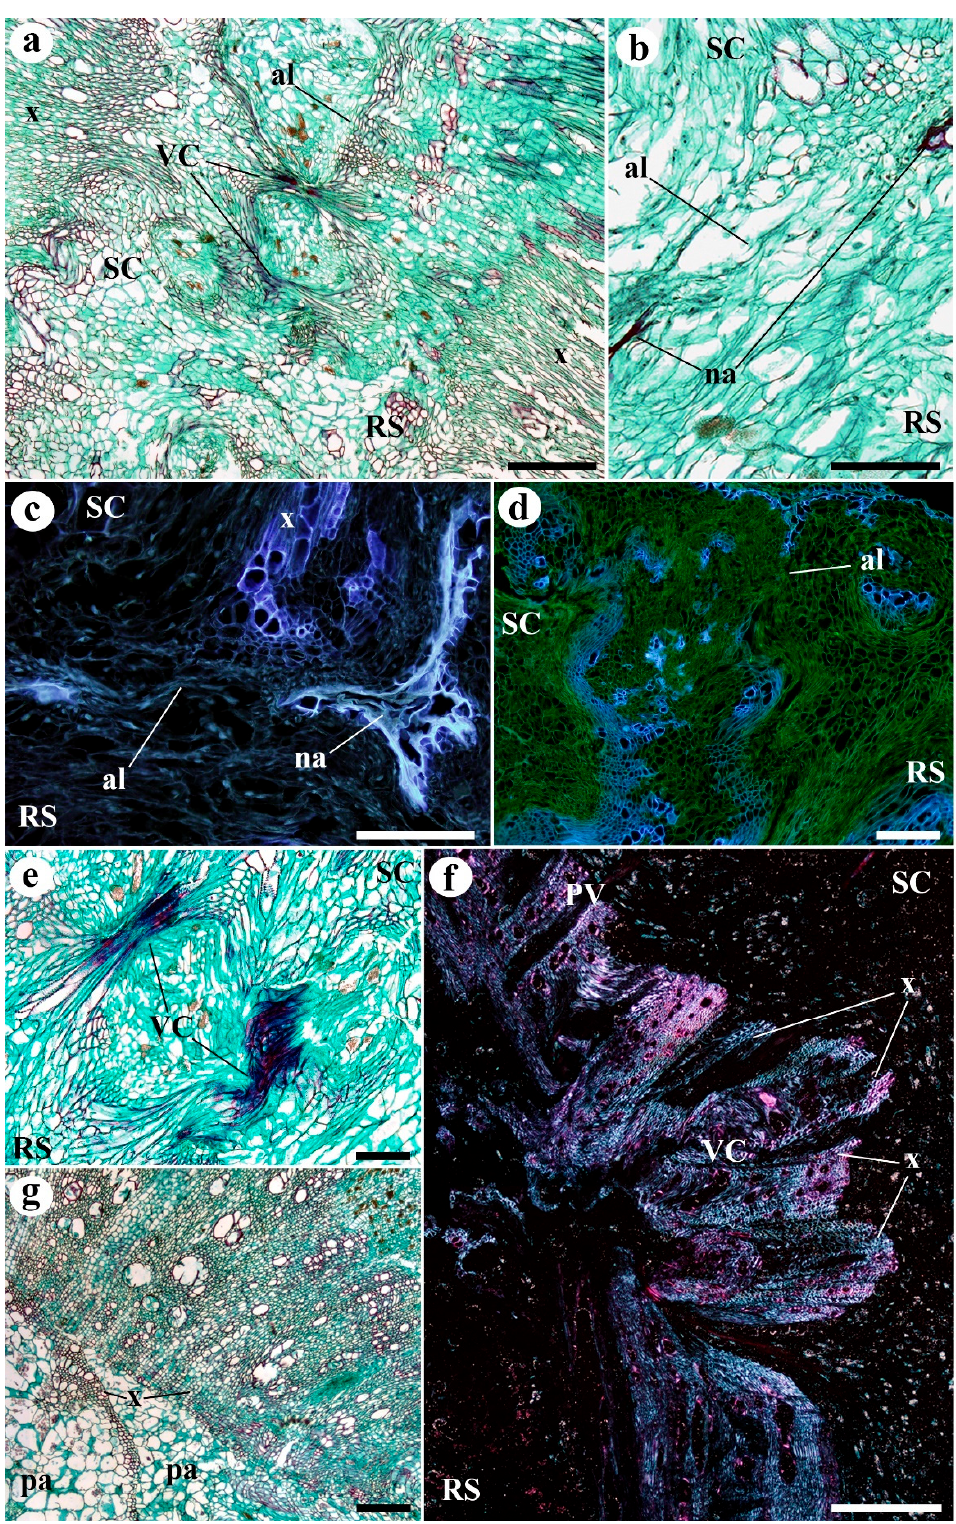
Figure 4. Representative images of ( a – c , f , g ) homografts and ( d , e ) heterografts at ( a – e ) 20 days and ( f , g ) 210 days after grafting (DAG). ( a ) Longitudinal section of the graft junction area. Note the large amount of vascular tissue, mostly xylem (x), and the vascular connections (VC). The adhesion line (al) is no longer so clearly visible. ( b , c ) Longitudinal section of the adhesion zone. The adhesion line (al) is hard to distinguish, but areas of non ‐ adhesion (na) are clearly visible. ( d ) Minibel (scion)–Marmande VR (rootstock) heterograft. Longitudinal section of the graft junction area. Note the large amount of vascular tissue, mostly xylem (x). ( e ) Marmande VR (scion)– Minibel (rootstock) heterograft. Longitudinal section of the graft junction. Note the vascular connections detail (VC). ( f ) Longitudinal section of the graft junction. Note the vascular connection (VC) now clearly formed. Note